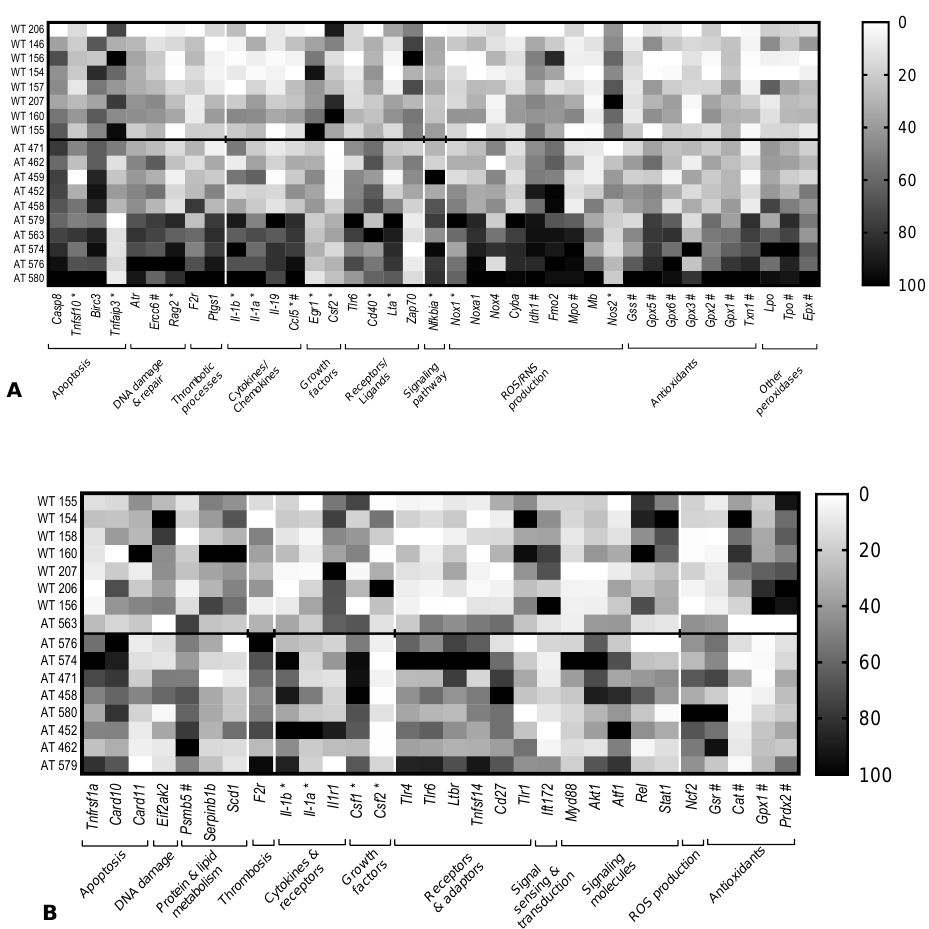
Figure 1. Heat maps of individual gene expression data in the hippocampus of 10 transgenic AT mice and 8 WT controls ( A ) and in the whole blood of 9 AT mice and 7 WT controls ( B ). Genes with |FR| > 1.5 and p < 0.05 in AT mice vs. WT controls are shown. Data are presented as 2 −ΔCT values and are scaled considering the highest value as 100%. Genes that are over-expressed in AT mice appear in dark tones in this group and in lighter tones in the control group. Genes that are under-expressed in AT mice appear in dark tones in the control group and lighter tones in diseased mice. NFkB target genes are marked with *, while redox-responsive genes are marked with